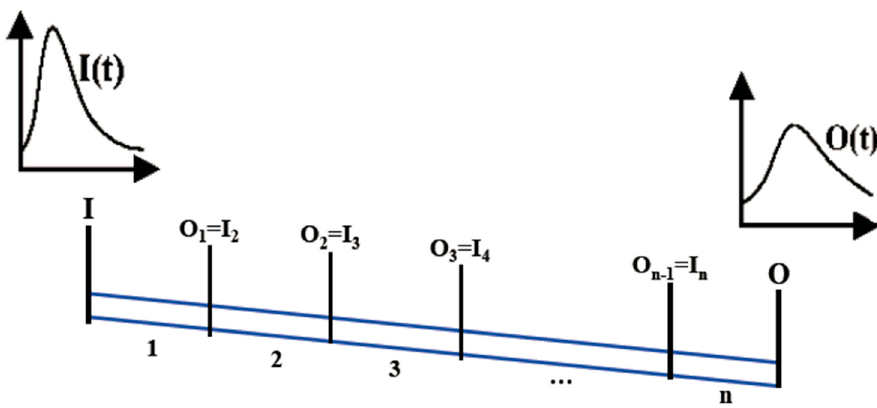
Figure 1. Discretization of the river stream.